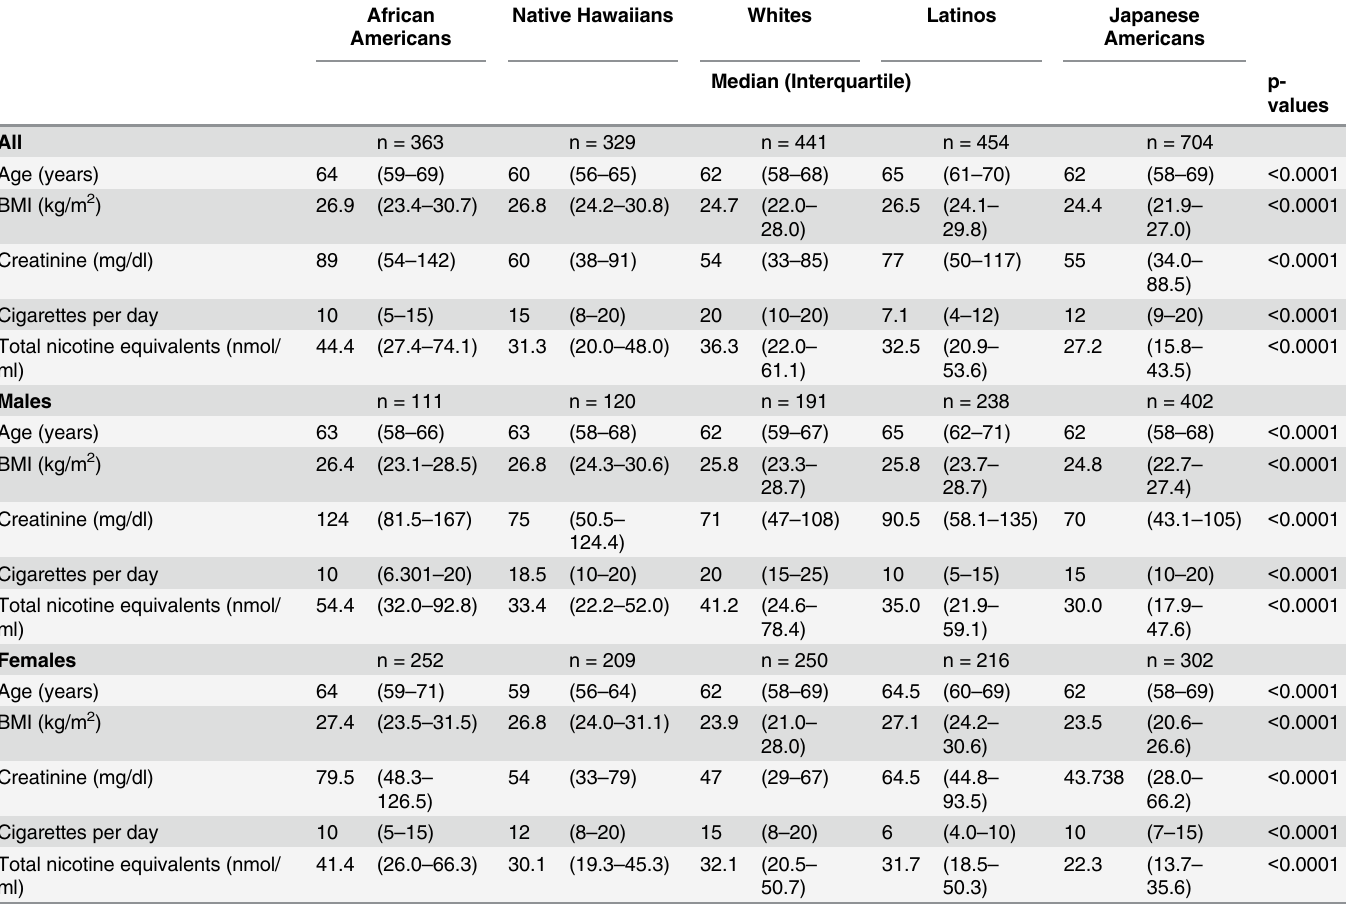
Table 1. Main characteristics of study participants a stratified by